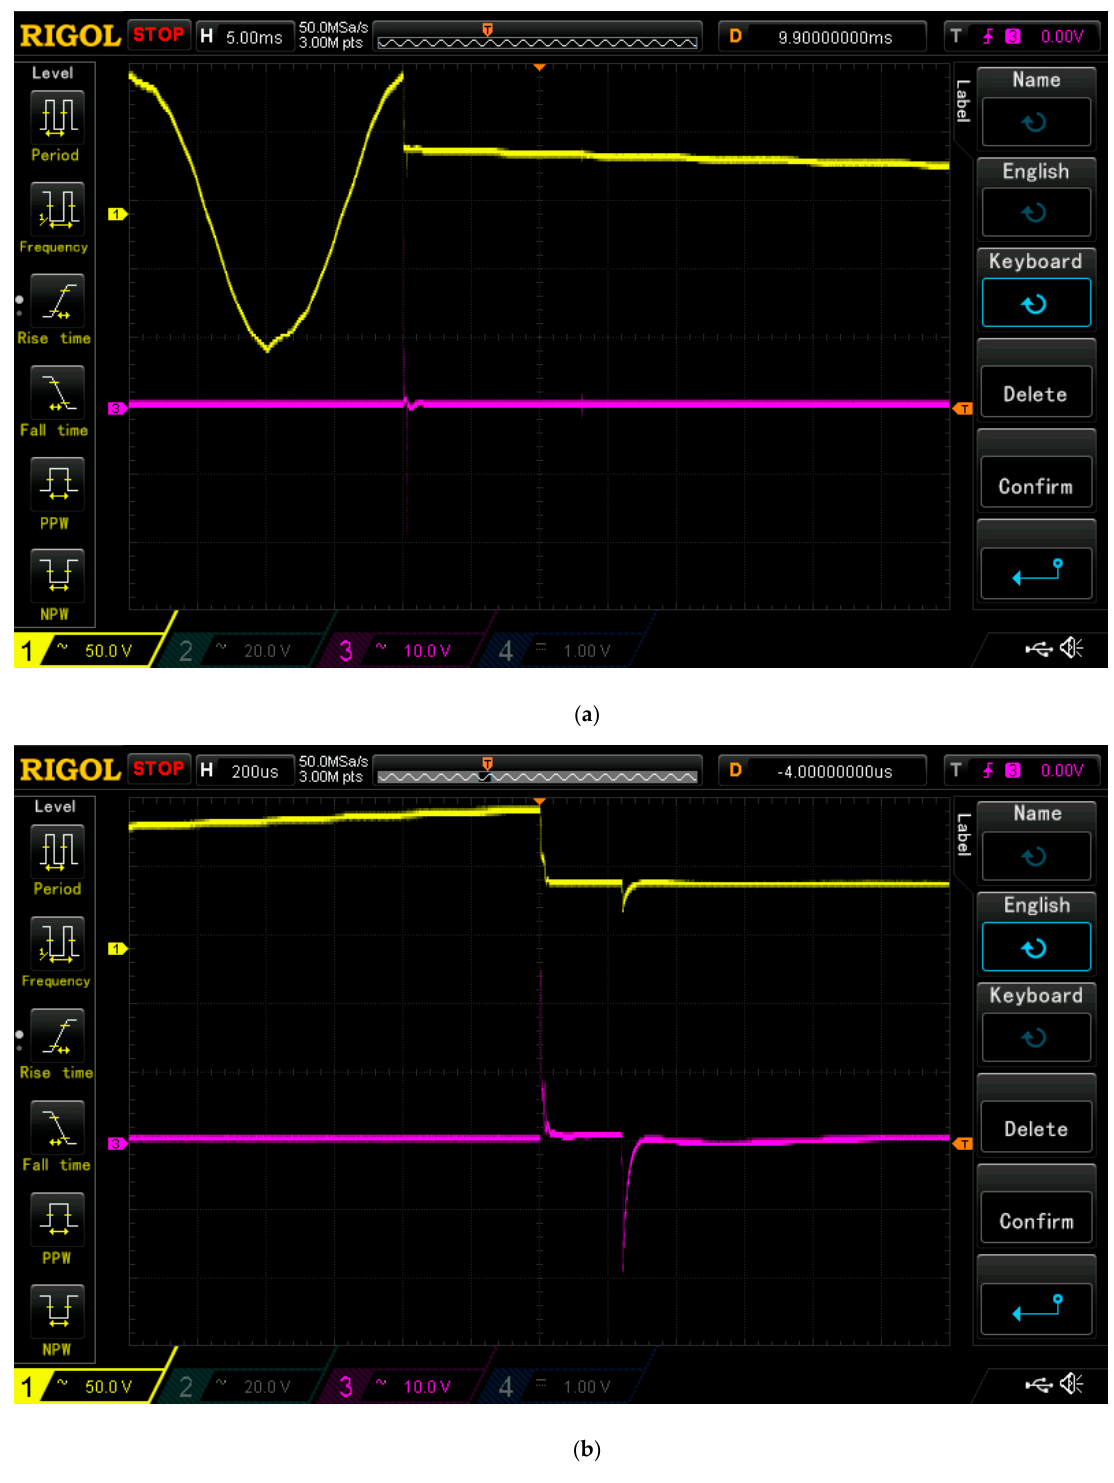
Figure 11. Figure of fault phase ( a ) and enlarged view ( b ) 2/ ψ = π